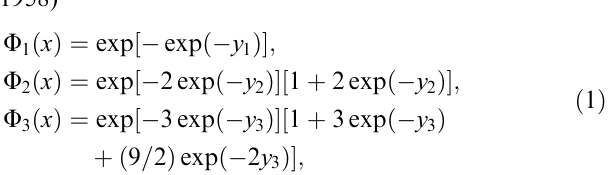
Table 1. Values and dates of the extreme daily aa indices for the three largest geomagnetic storms of solar cycles 9–22 (for solar-cycle numbers marked with *, the data are extracted from Nevanlinna (1995)